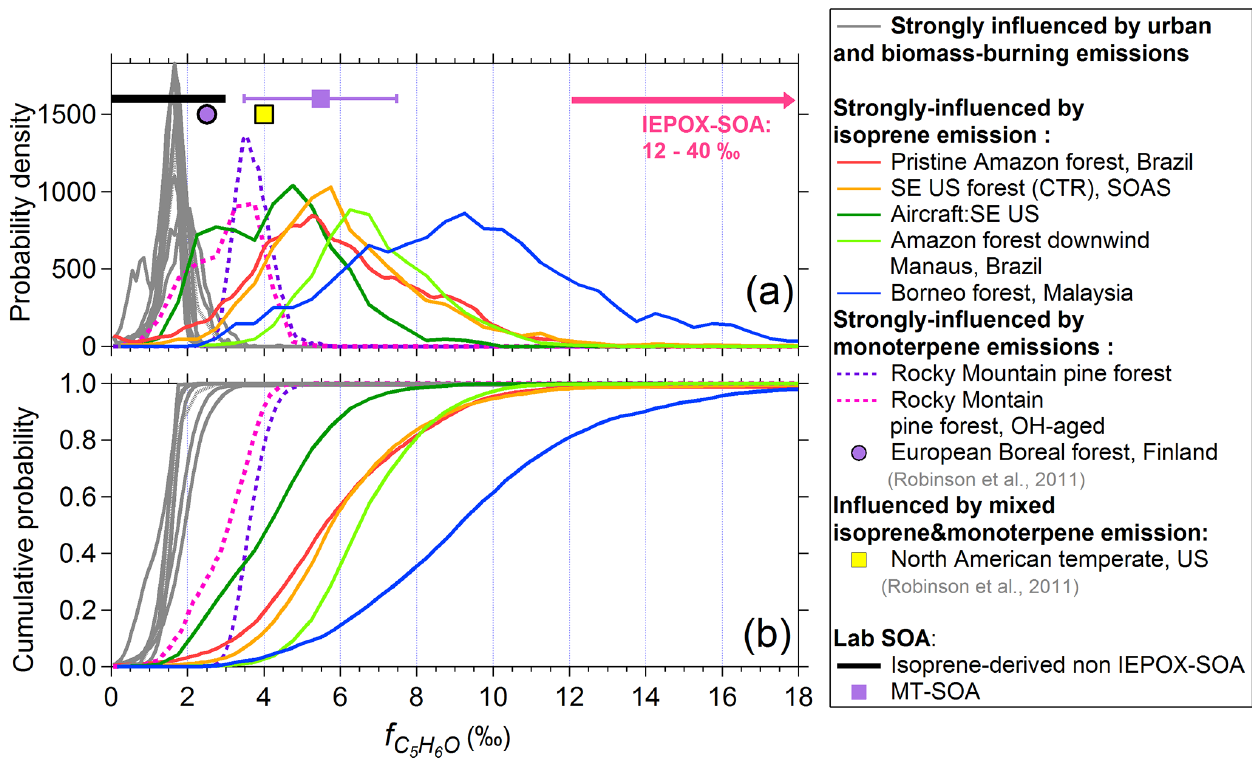
Figure 4. (a) Probability density and (b) cumulative probability distributions of f OA in studies strongly influenced by isoprene and/or C 5 H 6 O monoterpene emissions. The ranges of f C from other non-IEPOX-derived isoprene-SOA and MT-SOA are also shown. The background 5 H 6 O grey lines are from studies strongly influenced by urban and biomass-burning emissions and are the same data from Fig. 3a–b. The arrow in Fig. 4a indicates the range of f IEPOX-SOA between 12‰ (start of the arrow) to 40‰ which is beyond the range of x axis C 5 H 6 O